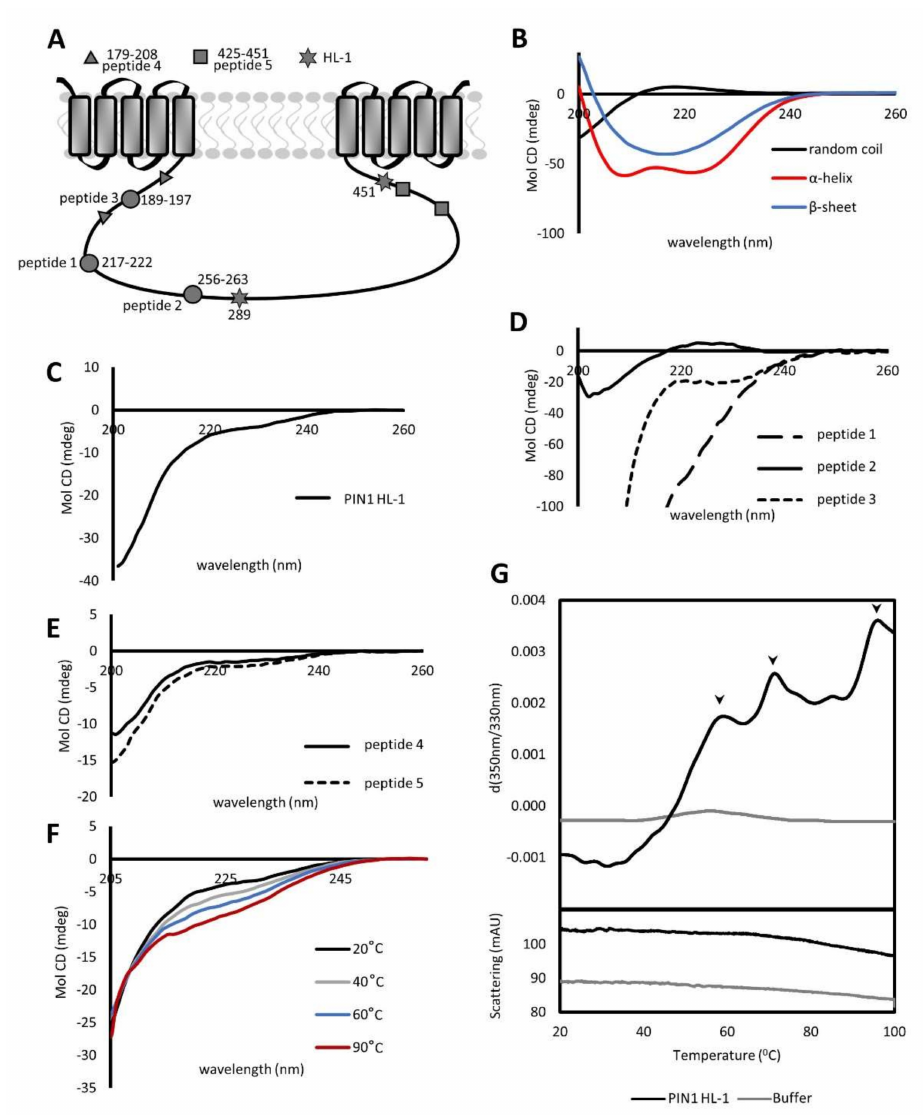
Figure 1. PIN1 hydrophilic loop contains thermally stable structured and unstructured parts reminis- cent of an intrinsically disordered protein region. ( A ) Schematic representation of A. thaliana PIN1 protein topology. Two transmembrane domain groups are divided by a long hydrophilic loop. Grey circles indicate approximate positions of short peptides selected based on computer modeling for circular dichroism. Triangles and squares mark the beginning and the end of long peptides. Stars mark the start and the end amino acid of the hydrophilic loop used for most of the later biophysical analysis. ( B ) Circular dichroism spectra of poly–L–lysine at pH 7 and 11. At pH 7 poly–L–Lys shows spectra specific for unstructured protein (black line), compared with its spectra at pH 11 where it has exclusively helical (red line) or β -sheet composition after heating to 60 ◦ C (blue line). ( C – E ) Circular dichroism spectra of PIN1 HL − 1, short and long peptides. ( F ) Thermal melting CD spectra of PIN1 HL–1 were obtained at different temperatures ranging from 20 to 90 ◦ C. The final spectrum is a representation of the average of three biological repetitions. ( G ) PIN1 HL–1 thermogram generated by nanoDSF indicating the presence of amino acid chain secondary structure in the Tyrosine surroundings (black line) overlaid with the buffer thermogram where no structure is detected (grey line). The X –axis presents the temperature and the Y –axis represents the first derivative of fluorescence intensity ratio 350 nm/330 nm. The bottom panel represents scattering data that do not detect protein